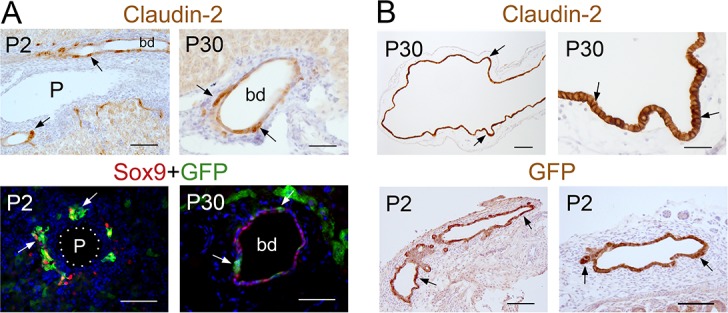
Claudin-2 and GFP proteins have identical expression in intrahepatic and extrahepatic biliary tissues of wildtype and Cldn2-EGFP mice.(A) Immunostaining results showing claudin-2 expression (arrows) in cells lining the intrahepatic bile ducts of wildtype newborn (P2) and adult (P30) mice (top panels), and GFP (arrows) co-expression with the cholangiocyte marker Sox9 in intrahepatic bile ducts of P2 and P30 Cldn2-EGFP mice (bottom panels). Scale bars: 100 µm (left, top), 50 μm (right, top and bottom panels). (B) Claudin-2 is highly expressed (arrows) in the gall bladder epithelium (top panels) of an adult wildtype mouse. GFP (arrows) is similarly expressed in the gall bladder (bottom, left) and the common bile duct (bottom, right) of a Cldn2-EGFP P2 mouse. Scale bars: 200 µm (left, top), 25 μm (right, top), 100 µm (bottom panels).